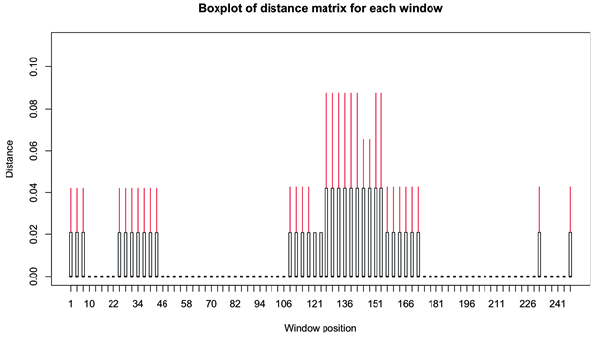
Figure 2. Mini-barcode sliding windows of trnL-F sequence in Avi- cennia species, showing genetic distance of Avicennia alba with the other studied